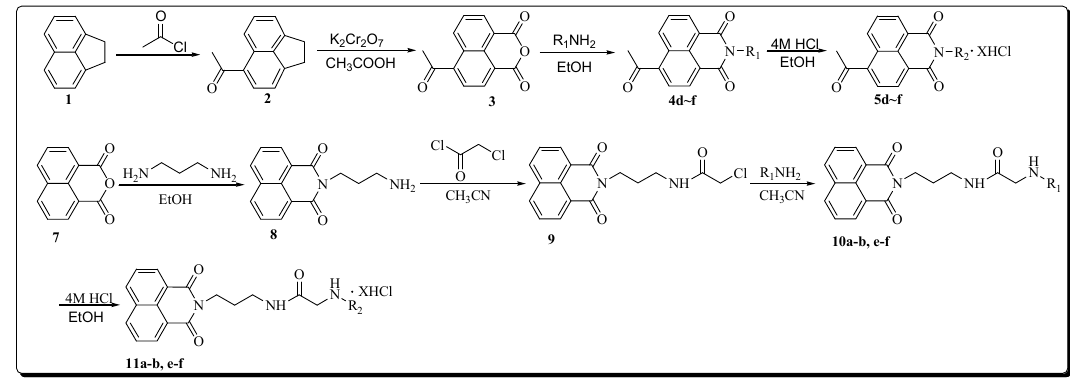
Scheme 1. Synthetic protocol of target compounds 5d – f , 11a – b , e – f (X = 2, 3, 4; R 1 = N -Boc protected polyamine chains; R 2 = deprotected polyamine chains).